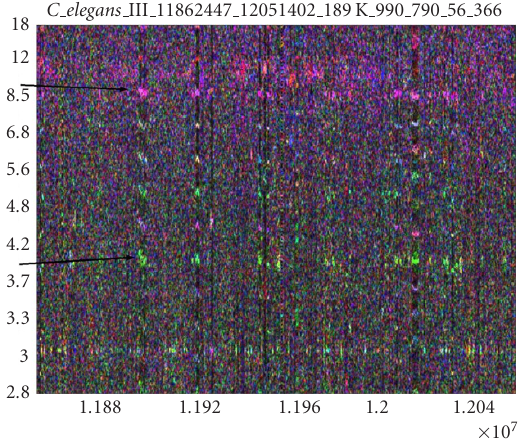
Figure 7: Spectrogram showing a strong coincident 10+-base peri- odicity in the same DNA sequence shown in Figure 6 (coincident with 300-base periodicity). This spectrogram corresponds to the rightmost arrow in Figure 6 and is 428 Kbp in length.